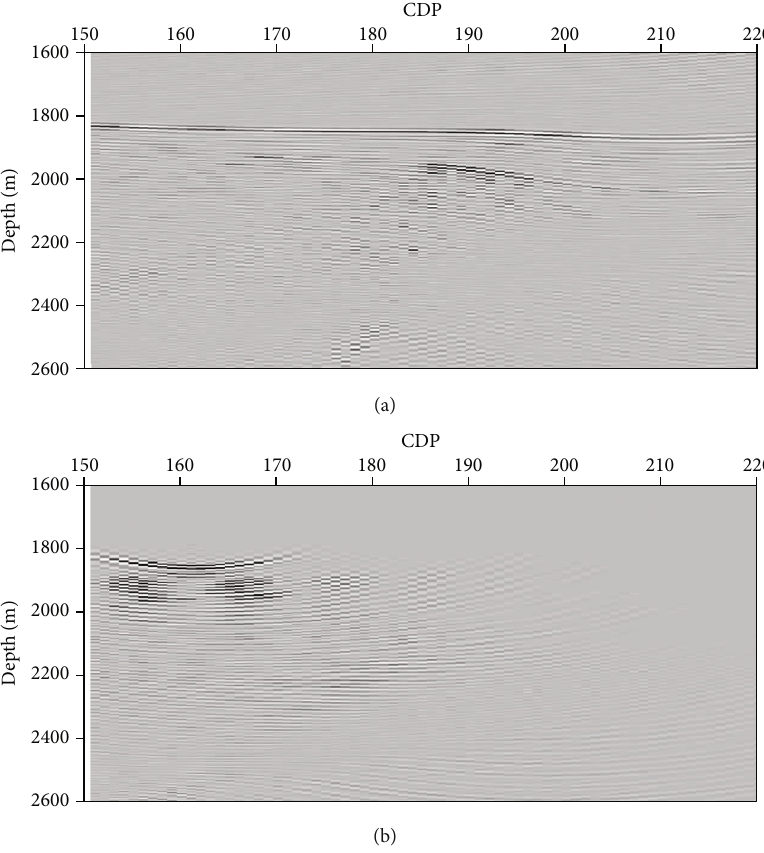
Figure 9: (a) Imaging result of multiple waves and (b) imaging result of primary